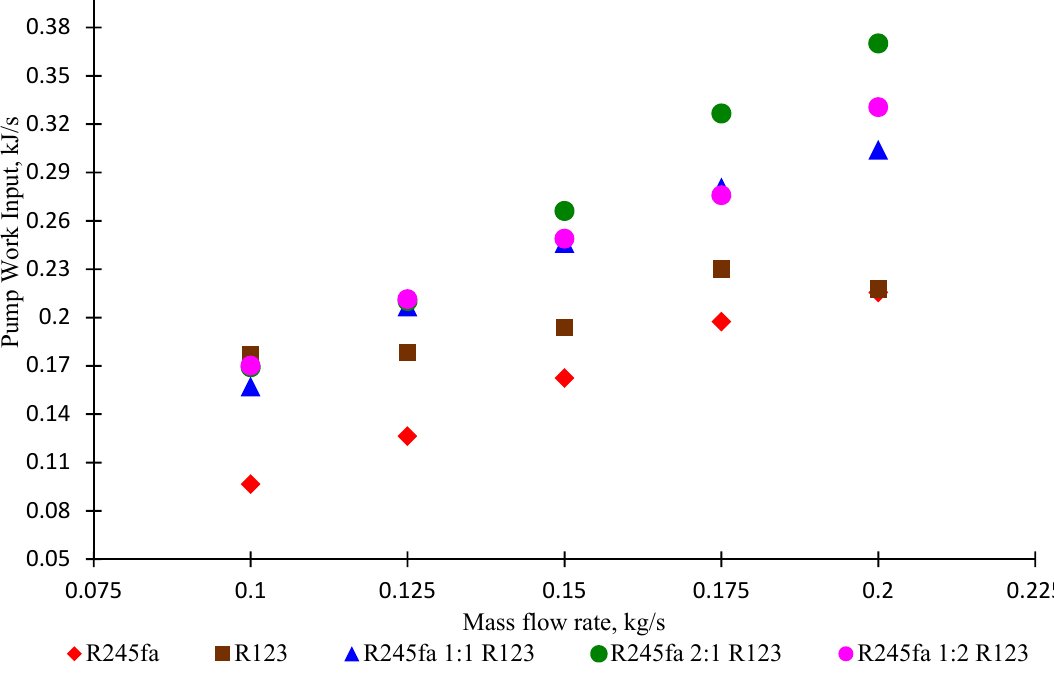
Figure 15. Pump work input as a function mass flow rate for R245fa, R123, and mixed working fluids with heat source at 120 ° C.